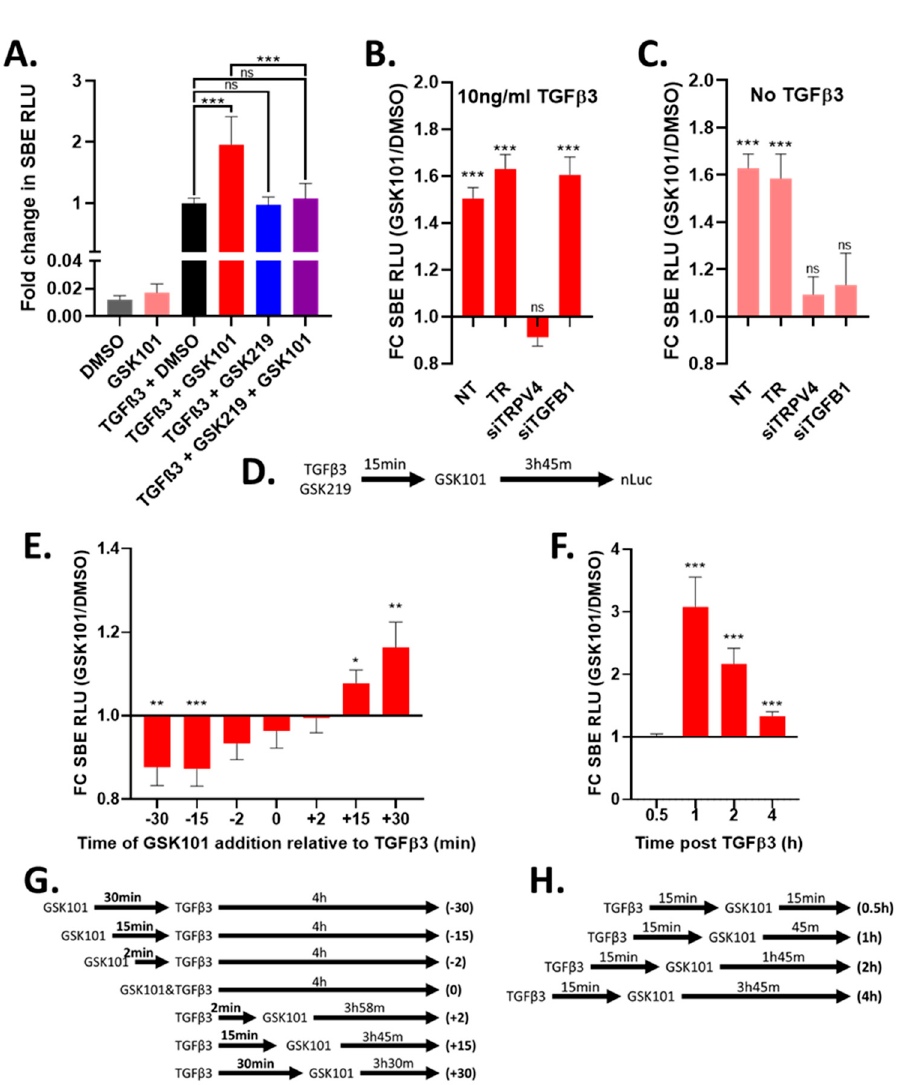
Figure 2. Activation of TRPV4 modulates TGF β signalling in a time-dependent manor. TC28a2 cells with SBE-nLUCp reporter were used to monitor TGF β signalling. ( A ) Cells were stimulated with 10 ng/mL TGF β 3 or medium control, incubated for 15 min then stimulated with 100 nM GSK101 (activator) or DMSO control (vehicle) and then incubated for a further 3 h 45 min before SBE-nLUCp activity was determined. TRPV4 inhibitor (500 nM GSK219) was added to cells along with TGF β 3. ( B ) and ( C ) Cells were either not transfected (NT), mock transfected (TR), transfected with siRNA to TGFB1 (siTGFB1) or transfected with siRNA to TRPV4 (siTRPV4) for 24 h and then serum starved and incubated for a further 48 h. Following incubation, cells were stimulated with TGF β 3 ( B ) or media control ( C ) and then TRPV4 activated using GSK101, SBE-nLUCp activity determined as described in ( A ). ( D ) Schematic illustrating the order of stimulation/activation for A–C. ( E ) Cells were stimulated with 10 ng/mL TGF β 3. TRPV4 was activated (100 nM GSK101/DMSO control) either before (-ve mins), with (0 min) or after (+ve mins) TGF β 3 stimula- tion. ( F ) Cells were stimulated with 10 ng/mL TGF β 3 or medium control, incubated for 15 min then TRPV4 activated using 100 nM GSK101 or DMSO control. SBE-nLUCp activity was deter- mined after the indicated amount of time post TGF β 3 stimulation. ( G ) Schematic representation of conditions shown in E. ( H ) Schematic representation of conditions shown in F. FC SBE RLU; fold change in SMAD-binding element relative light units NT; no treatment. Data in A combined from four independent experiments, and data in B–F combined from three independent experiments. Raw data are shown in Figures S3 and S5. GSK101 treatment was normalised to the DMSO control for each siRNA/timepoint. Statistical differences were calculated by two-way ANOVA followed by Sidak’s multiple comparisons test; p < 0.05 *, p < 0.01 **, and p < 0.001 ***.